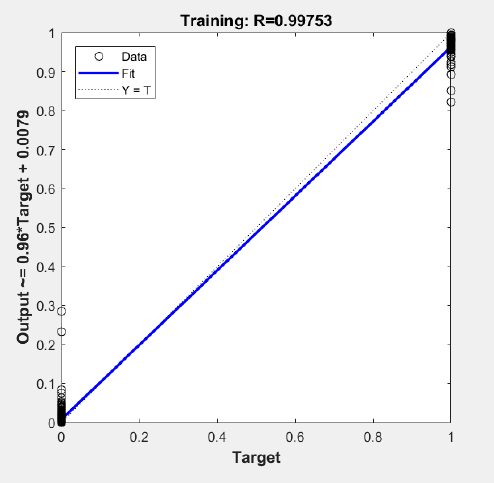
Figure 21. Regression curve of neural network training error.